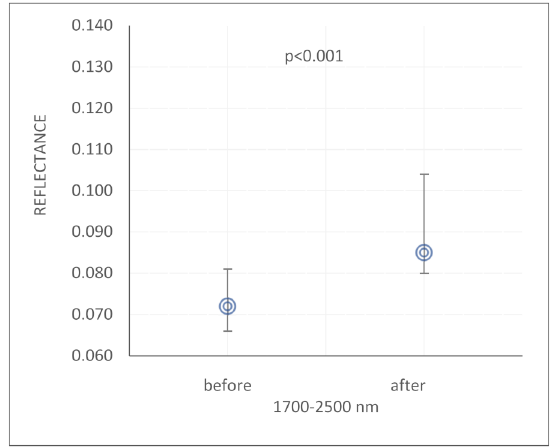
Figure 14. Median and quartile range of reflectance at the wavelength of 1700–2500 nm in the group of women undergoing microdermabrasion, before and after the